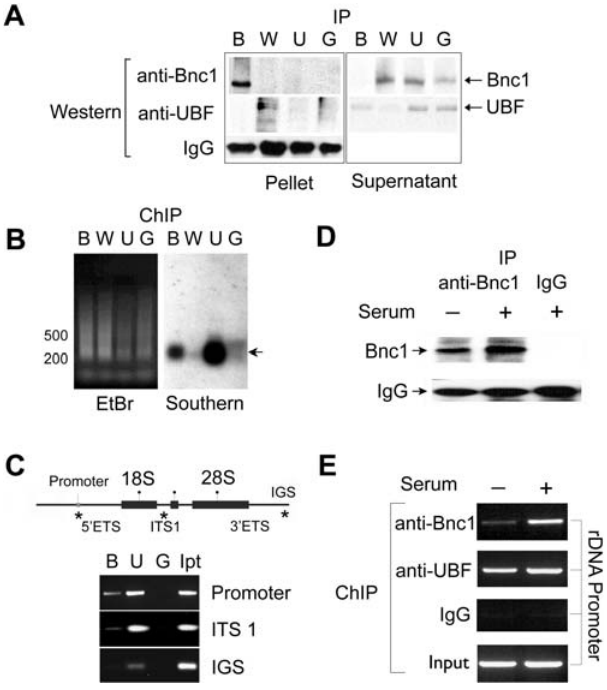
Figure 1. Basonuclin interacts with rDNA promoter in vivo. A , Western analyses of immunoprecipitated proteins from HaCaT cell lysate. The IP antibodies are shown above the Western blot; B, anti-basonuclin (alpha- hB34), U, anti-UBF, W, anti-WT protein, and G, IgG from a naive rabbit. The detecting antibodies are indicated on the left. The target proteins were monitored in both the pellet and supernatant. Note that no cross- reactivity was observed. B , The resolution of the ChIP assay was assessed by a Southern analysis. A primer was ligated to the immunoprecipitated DNA, which was then amplified by PCR. The amplified DNA was separated by agarose electrophoresis and visualized by ethidium bromide (EtBr). The DNA was then transferred to a nylon membrane and probed with an rDNA promoter probe (Southern). The chromatin immunoprecipitation (ChIP) antibodies are indicated above the gel by letters described in ( A ). A DNA size marker is shown on the left. The DNA fragments detected by the probe are indicated with an arrow on the right. C , Basonuclin’s association with three regions of rDNA was investigated with ChIP-PCR. The top panel depicts a generic rDNA transcription unit. Indicated are the promoters, the rRNA coding sequences (18S and 28S), the external and internal transcribed spacers (ETS and ITS) as well as the intergenic spacer (IGS). Regions tested by PCR are indicated with a (*). Twice-ChIP-precipitated DNAs were used as template for PCR, whose products were analyzed by electrophoresis (lower panel). The ChIP antibodies are indicated above the gel (B, U, G, as in A, Ip, Input DNA). PCR specificity is shown on the right. D , Basonuclin level in HaCaT cells cultured in the presence ( + ) and absence (-) of serum. Basonuclin was immunoprecipitated from cell lysate and analyzed by Western blot. The precipitation antibodies are indicated above the gel image and the Western detecting antibodies on the left. E , The association of basonuclin and UBF to rDNA promoter in the presence and absence of serum. ChIP-precipitated DNA was used as templates for PCR detection of the rDNA promoter. ChIP-antibodies are listed to the left of gel